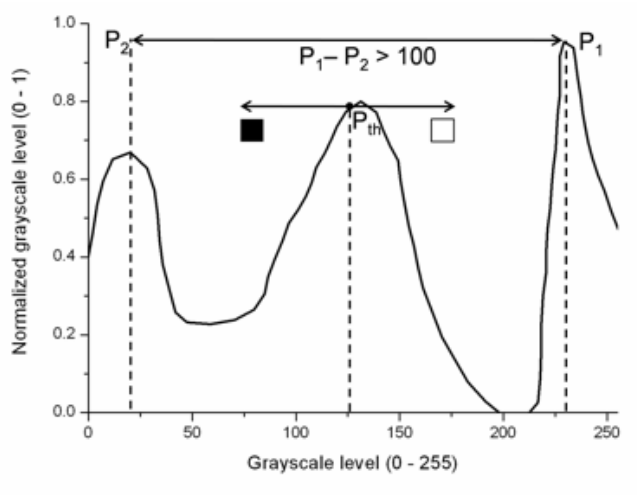
Figure 9. Scheme of the bimodal